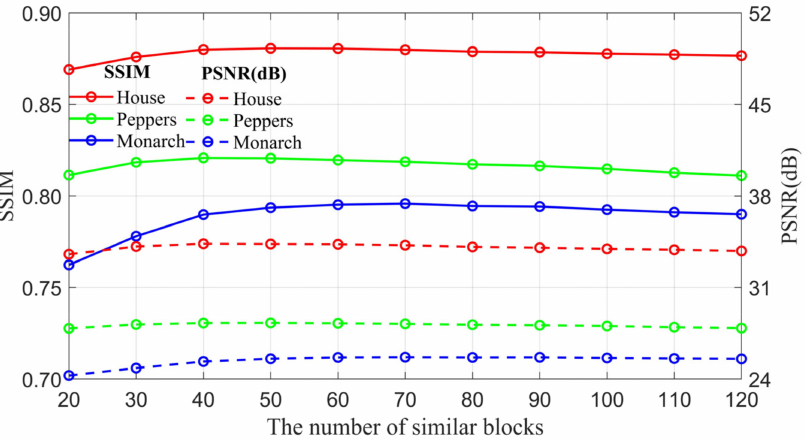
Figure 6. The SSIM and PSNR with the number of similar blocks for three